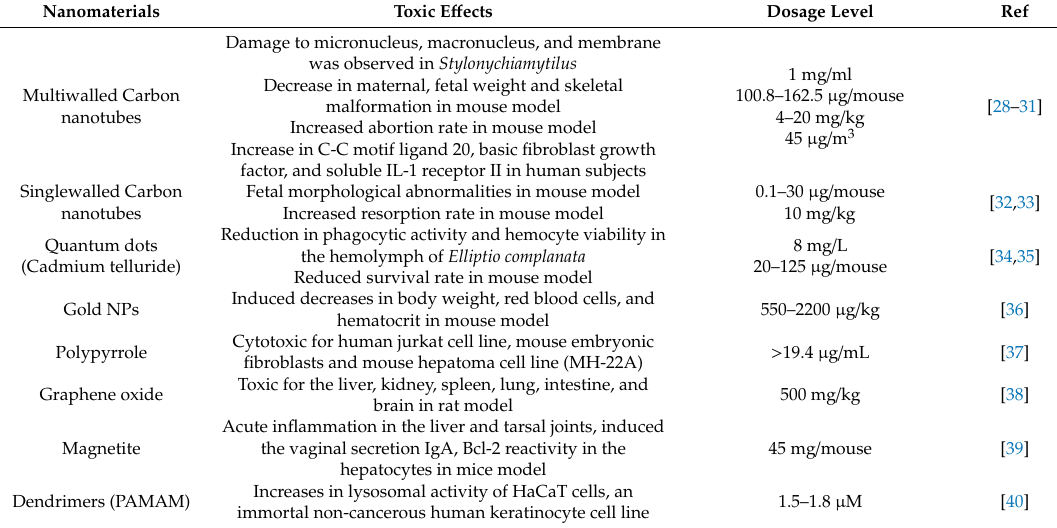
Table 2. Toxicity studies of various used in sensor development under in vitro and in vivo conditions.